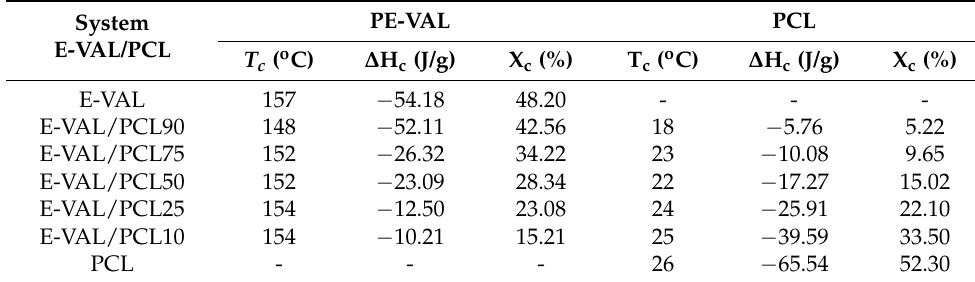
Figure 5. DSC cooling thermograms of E-VAL/PCL blends and their components. Table 4. Temperatures and heats of crystallization of E-VAL/PCL blends and their pure